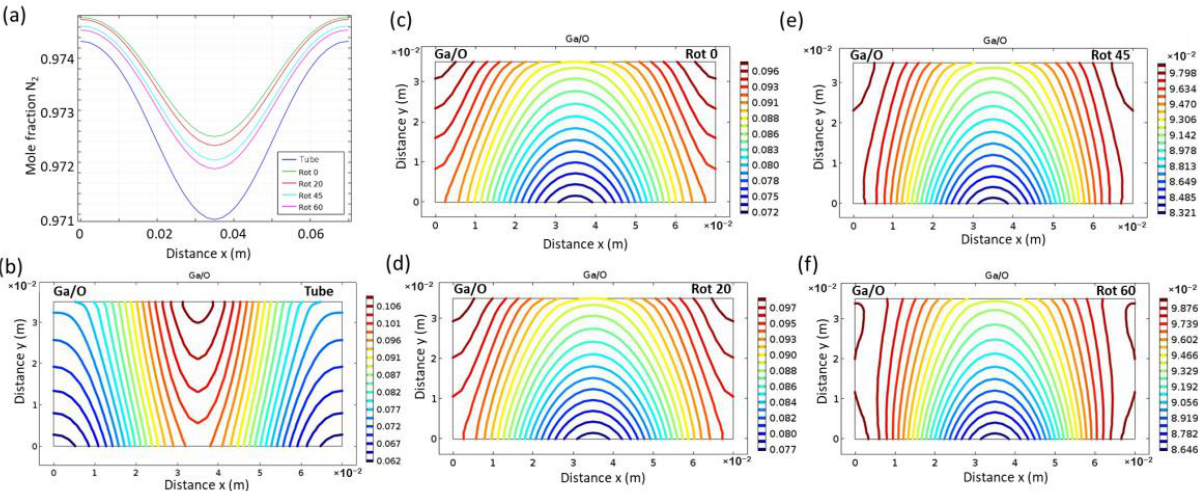
Figure 3. ( a ) Plots of the N 2 molar fraction calculated on the surface of the sample holder along the x-axis for the coordinate y = 1 cm. ( b ) The 2D distribution of the Ga/O ratio on the surface of the sample holder, calculated for the model using a tube as the gas inlet, and the 2D distribution of the Ga/O ratio on the sample holder calculated for a shower head with a rotation angle for outlets of 0 degrees ( c ), 20 degrees ( d ), 45 degrees ( e ), and 60 degrees ( f ). All calculations were performed for T = 850 °C and for GaCl and O 2 gas flows of 10 and 50 sccm, respectively.